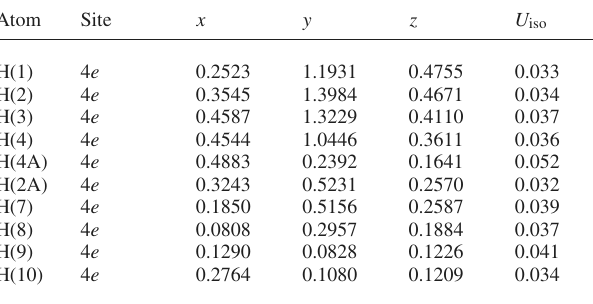
Table 2. Atomic coordinates and displacement parameters (in Å 2 )